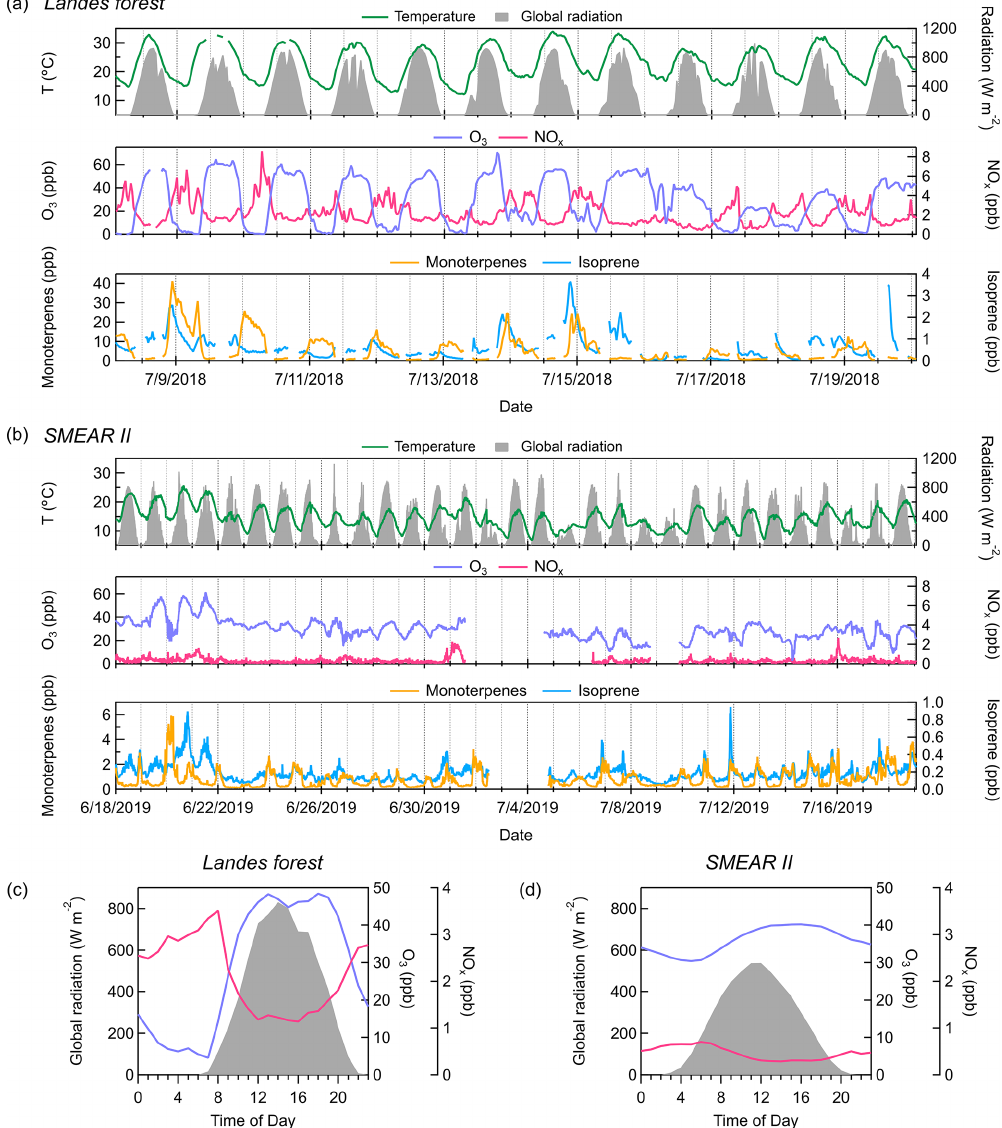
Figure 2. Time series of temperature, global radiation, concentrations of O 3 and NO x , and mixing ratios of monoterpenes and isoprene throughout the measurements (a) in the Landes forest and (b) at the SMEAR II station. Average diurnal cycles of global radiation, O 3 concentration (in blue), and NO x concentration (in pink) (c) in the Landes forest and (d) at the SMEAR II station. All parameters, except monoterpenes and isoprene, are shown on the same y -axis scale for the two sites. Monoterpene and isoprene concentrations are much lower at the SMEAR II station than in the Landes